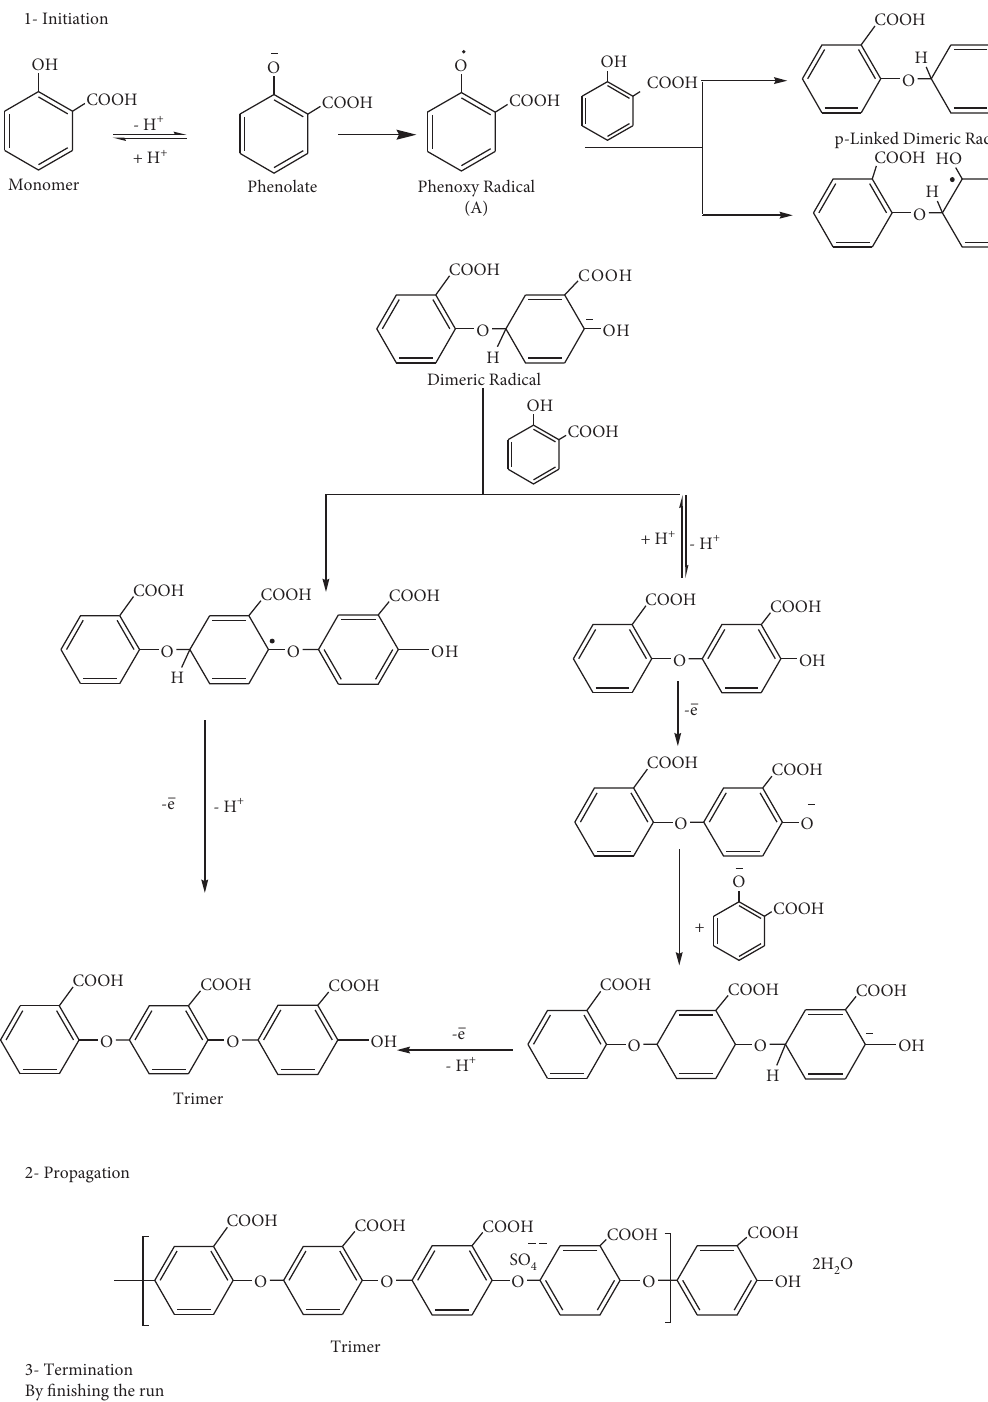
Scheme 1: Mechanism of electropolymerization reaction of salicylic (3) Efect of Temperature and Calculation of Termodynamic Parameters . Figure 6(a) represents the potentiodynamic polarization curves as a function of the solution temperature in the range between 298 and –313 K under the optimum